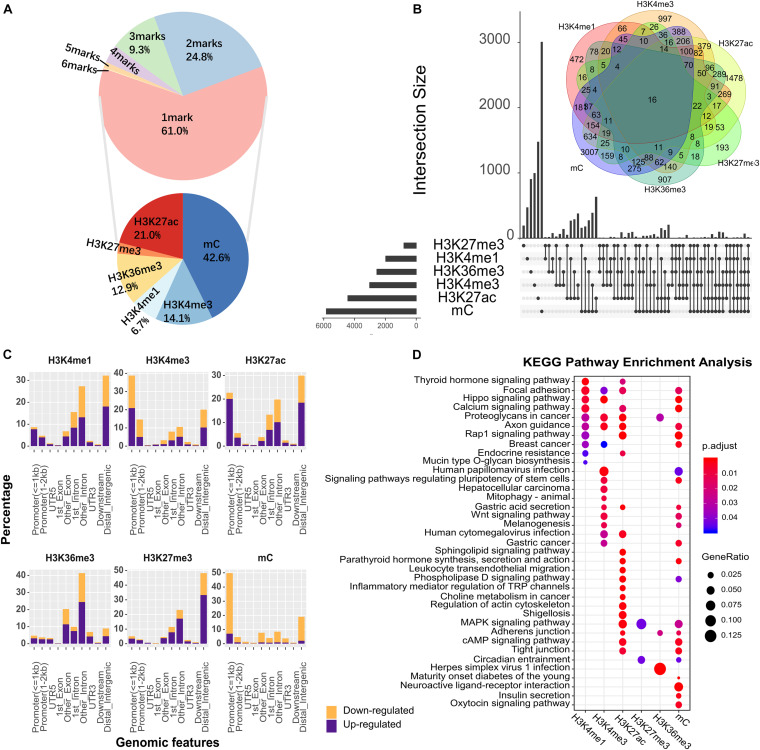
The epigenetic alteration for different genomic features in GC. (A) The proportion of genomic regions occupied by different numbers of epigenetic alterations. In the upper pie chart, 61% of genomic region were occupied by 1 epigenetic mark, and the remaining regions were co-occupied by varying numbers of epigenetic marks. Base on the genomic region occupied by 1 mark, the lower pie chart showed the proportion of genomic regions occupied by different types of epigenetic marks. (B) Overview of co-localization for each epigenetic modification. The intersection area indicates the count of co-altered epigenetic modifications, corresponding to the number in the Venn diagram. Different types of epigenetic marks altered together were connected by black lines. (C) The percentage of genomic features with altered epigenetic modifications. Upregulated and downregulated epigenetic modifications were colored in purple and orange, respectively. (D) KEGG enrichment analysis for all DHMRs. The X-axis denotes different types of epigenetic modification.